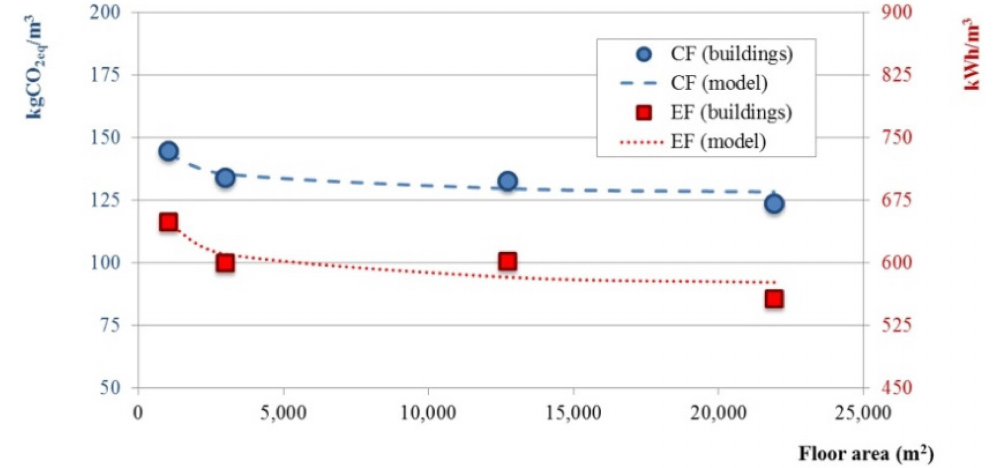
Figure 5. Carbon ( blue ) and Energy ( red ) footprint comparison of the four selected buildings ( points ) vs . the model ( lines ) for the reference scenario per unit